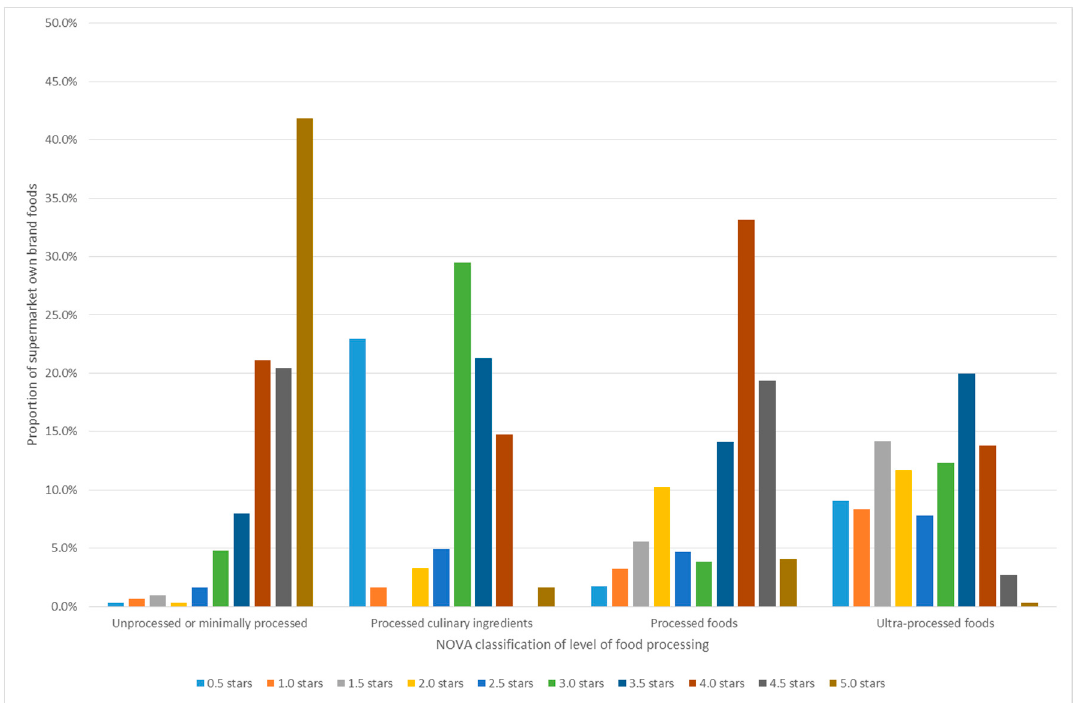
Figure 3. Frequency of Health Star Rating scores for supermarket own brand foods classified using the NOVA level of food processing.